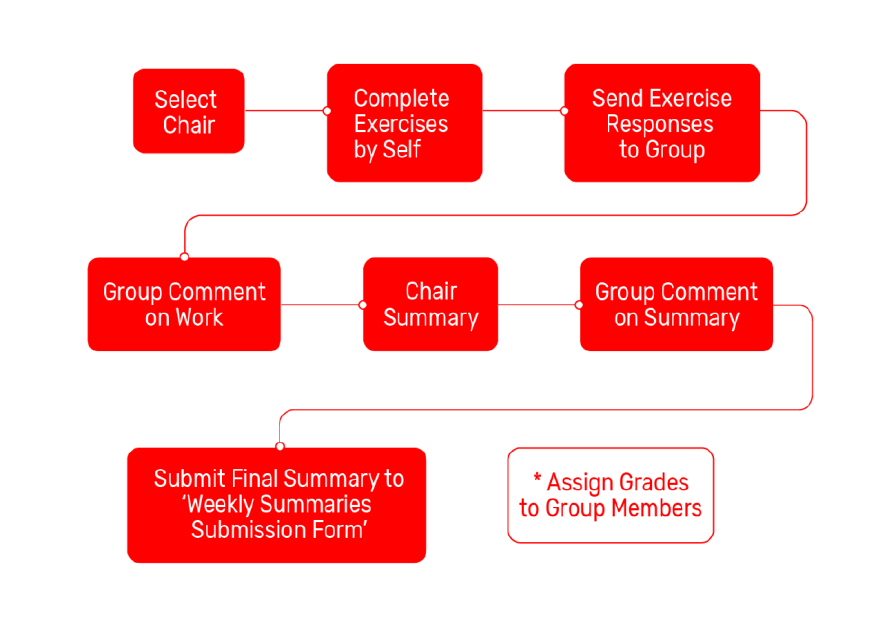
FIGURE 1. SKILLS FOR SUCCESS IN SOCIOLOGY COURSE